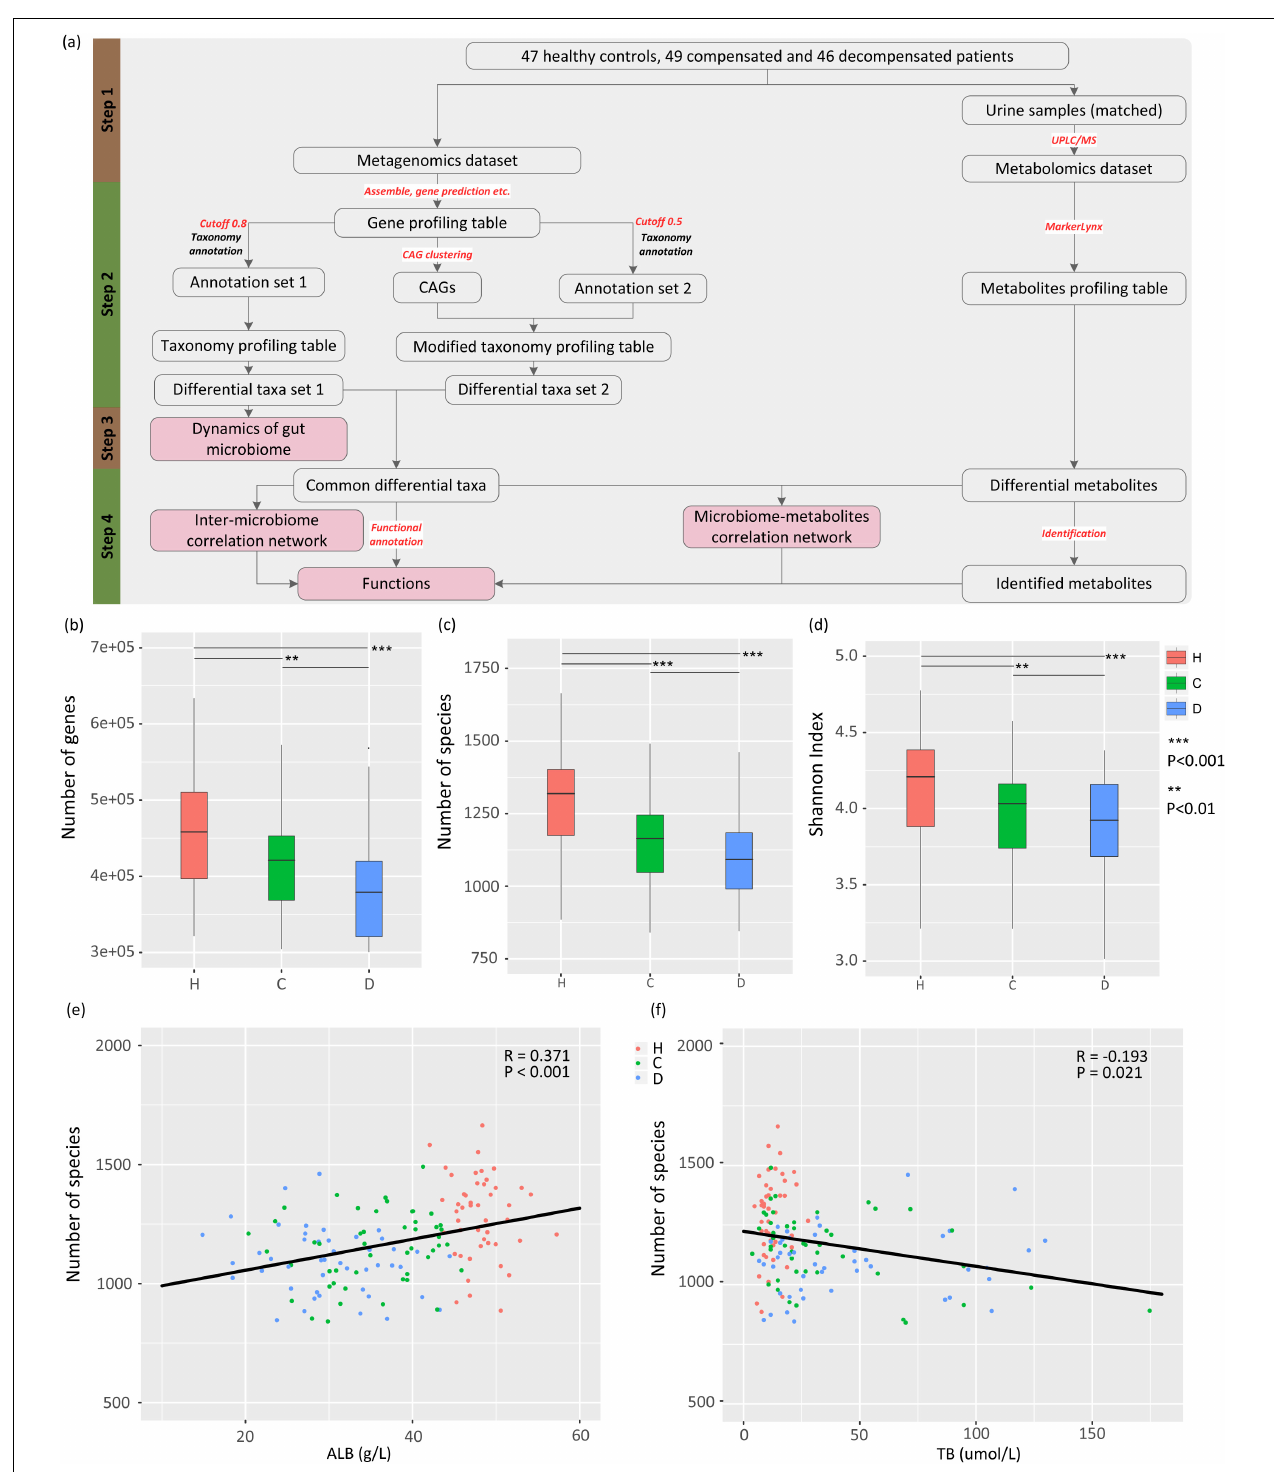
FIGURE 1 | Study design, and associations between gut microbiome and disease progression. (A) Schematic diagram of the study design. (B) Boxplot of microbial gene richness in healthy controls, compensated and decompensated patients. (C) Boxplot of microbial richness in healthy controls, compensated and decompensated patients. (D) Boxplot of the Shannon index in healthy controls, compensated and decompensated patients. (E) Correlations between microbial richness and albumin. (F) Correlations between microbial richness and total bilirubin.